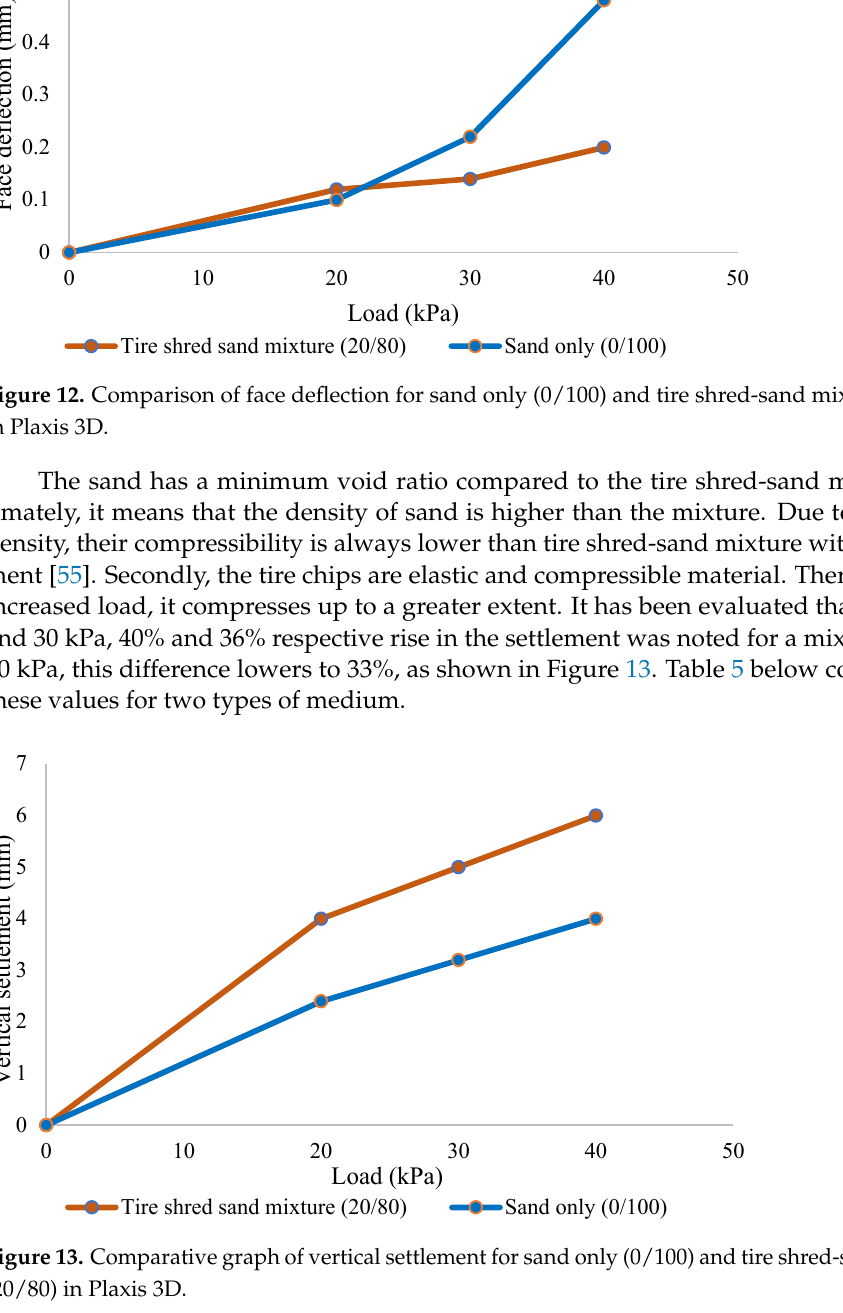
Table 5. Comparative values of tire shred-sand mixture with reinforcement and only sand with reinforcement from Plaxis 3D.